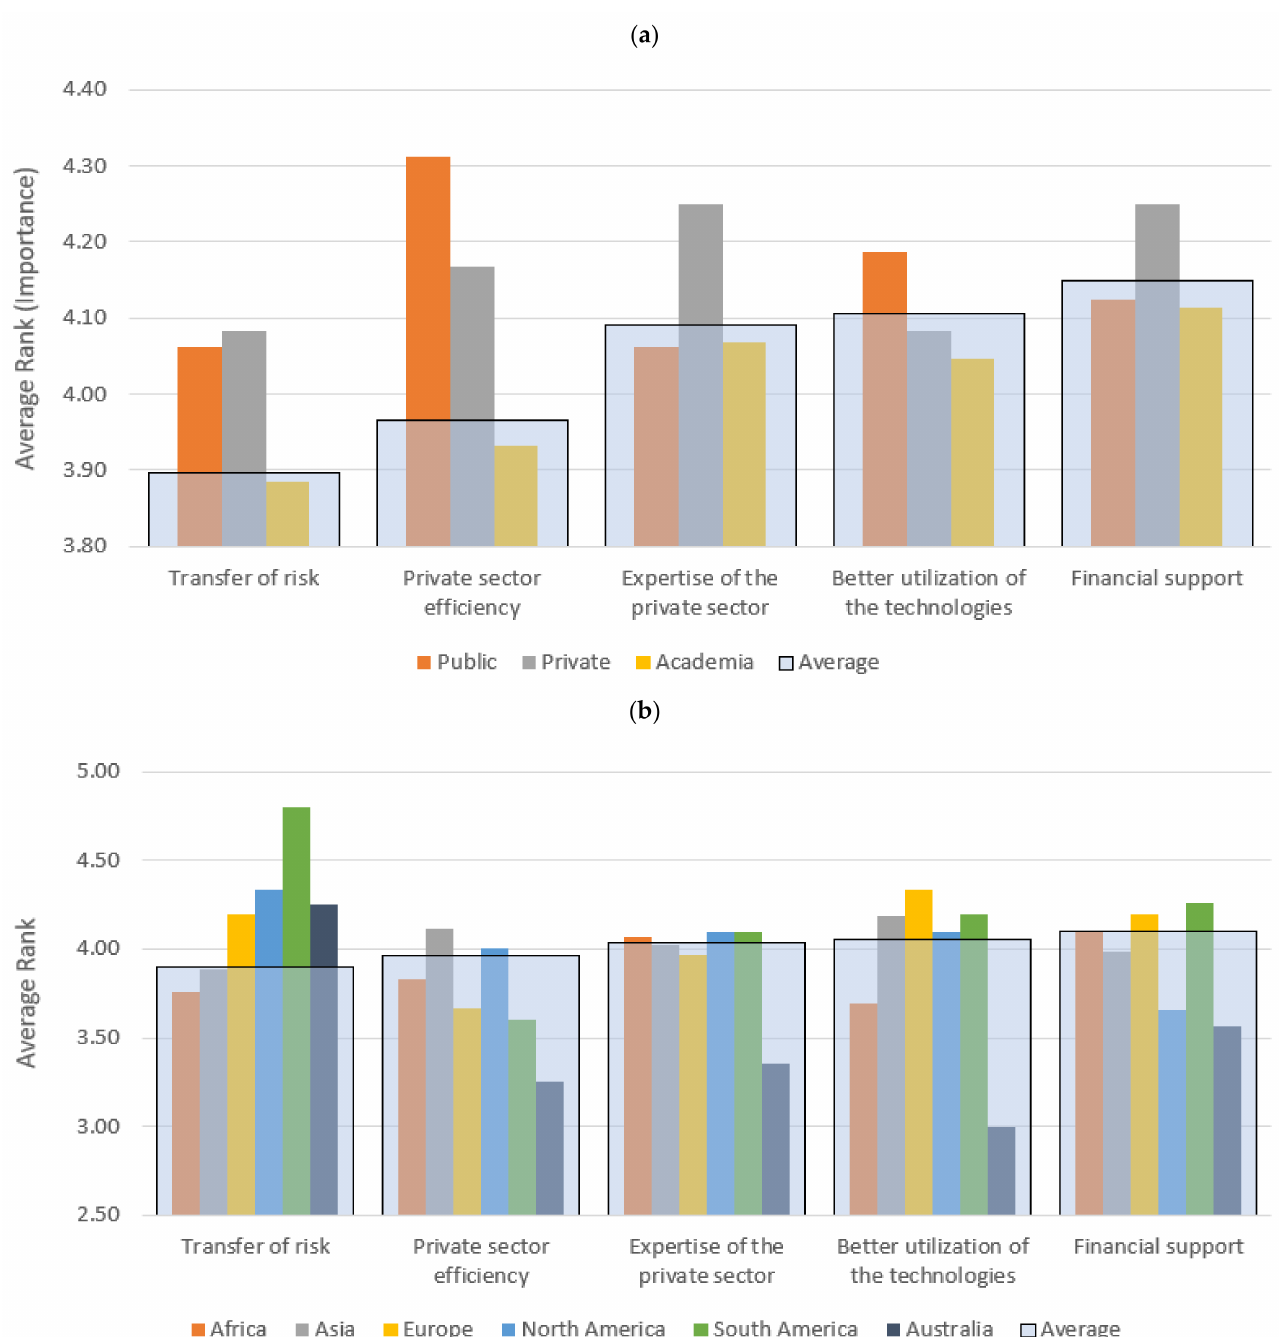
Figure 1. Average level of importance for every factor motivating the adoption of PPPs for renewable- energy projects ( a ) by sector, ( b ) by